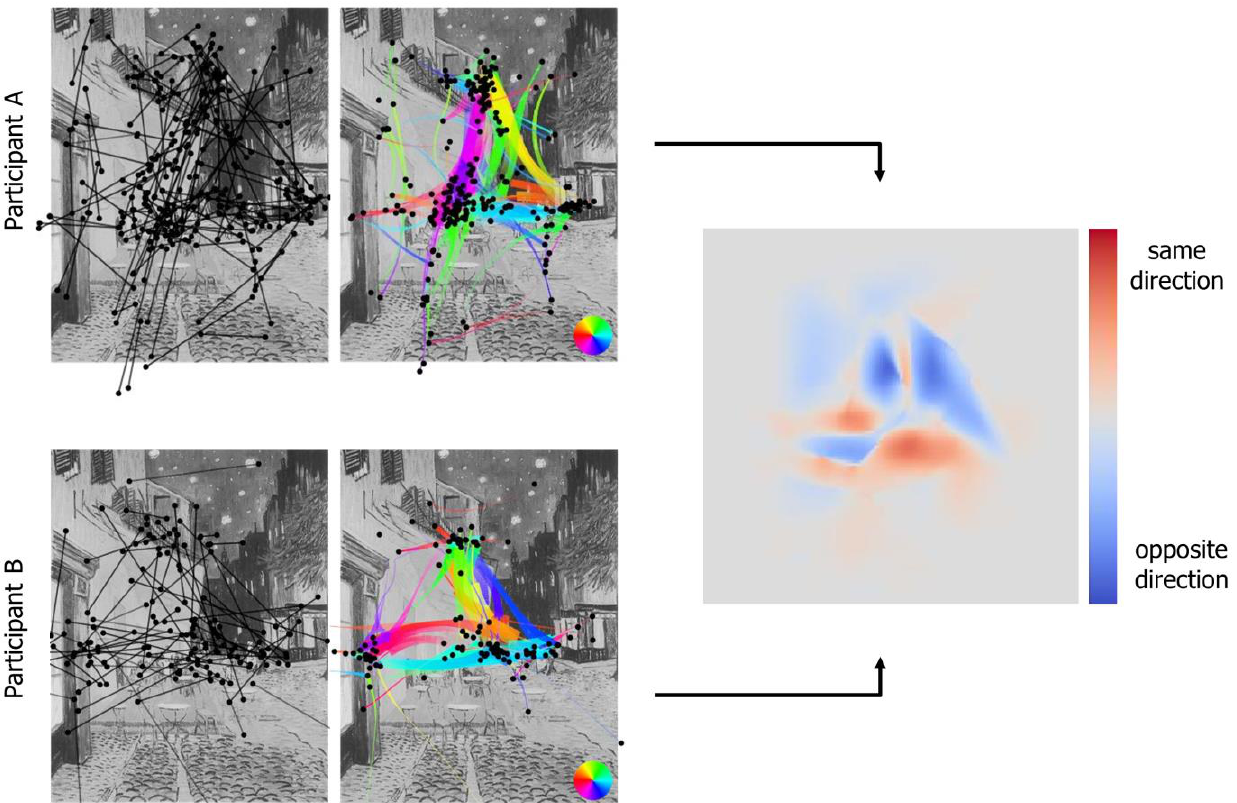
Figure 9. Comparison of scanpaths of two participants who observed the Vincent van Gogh painting. The similarity map is given by cosines between the two flow direction